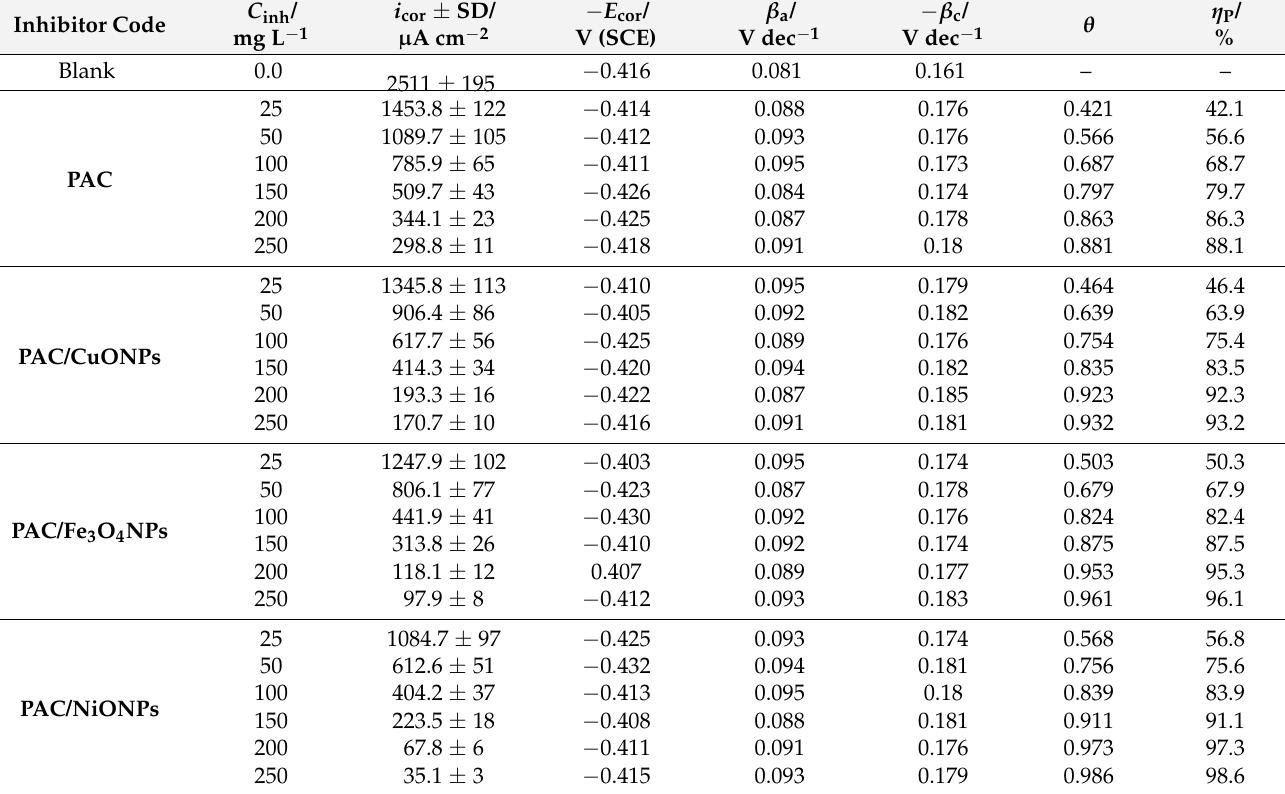
Table 1. PDP parameters for C-steel in molar hydrochloric acid without and with different concentrations of the as-prepared nanocomposite inhibitors at 50 ◦